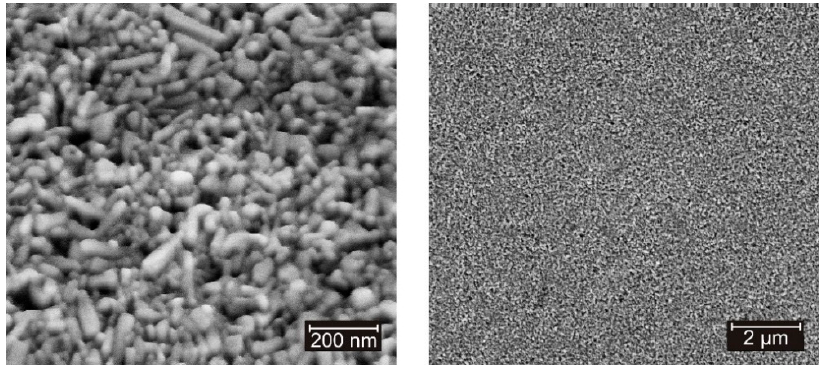
Figure 12. Scanning electron microscope images of the ZnO nanoparticle layer after the solvent evaporation at 115 °C in a convection oven for 1 h and the UV/wet ‐ air treatment.